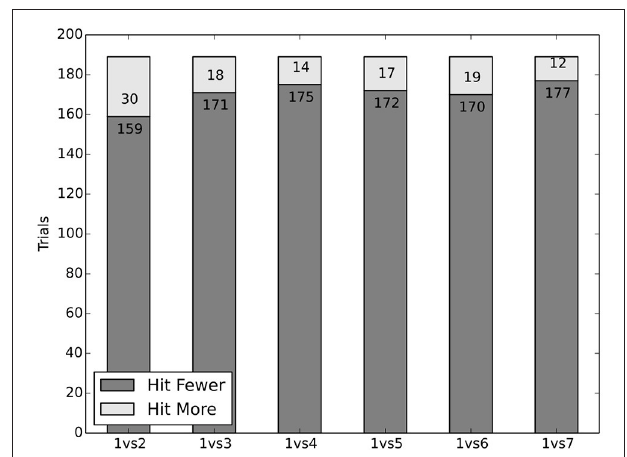
FIGURE 5 | Subjects opted to hit fewer people, not to avoid sidewalk.